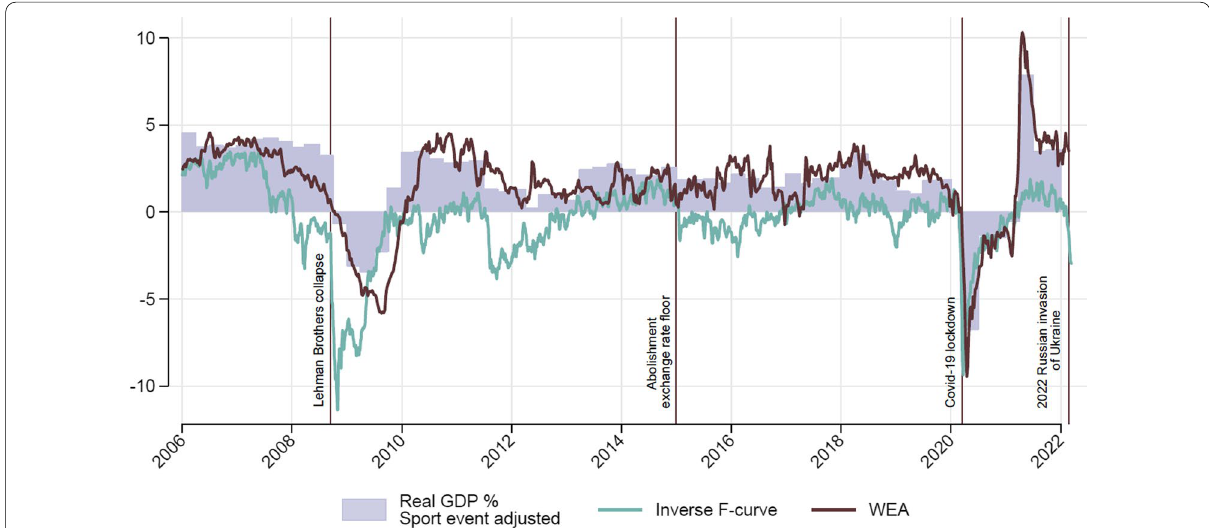
Fig. 1 Measurement and alternative indicators of Swiss GDP, data sources mentioned in the main